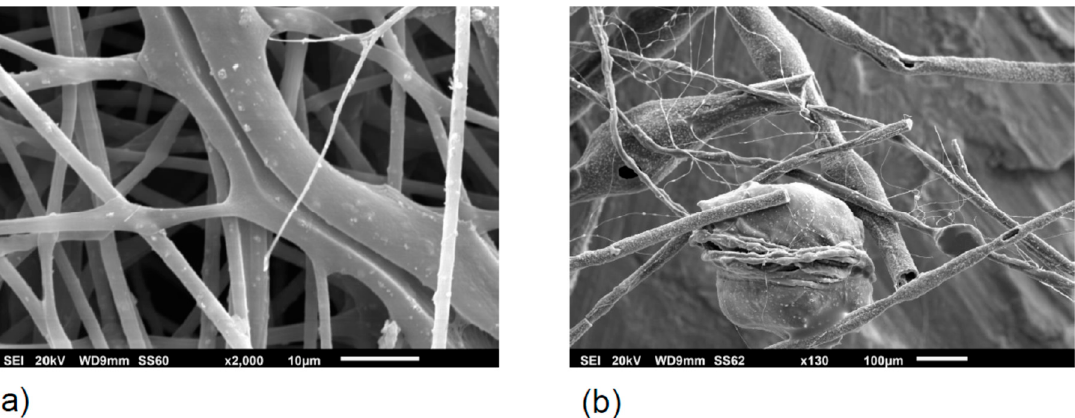
Figure 3. SEM images of oxide particles/fibers ( a ) and composite fibers ( b ) with different sizes.